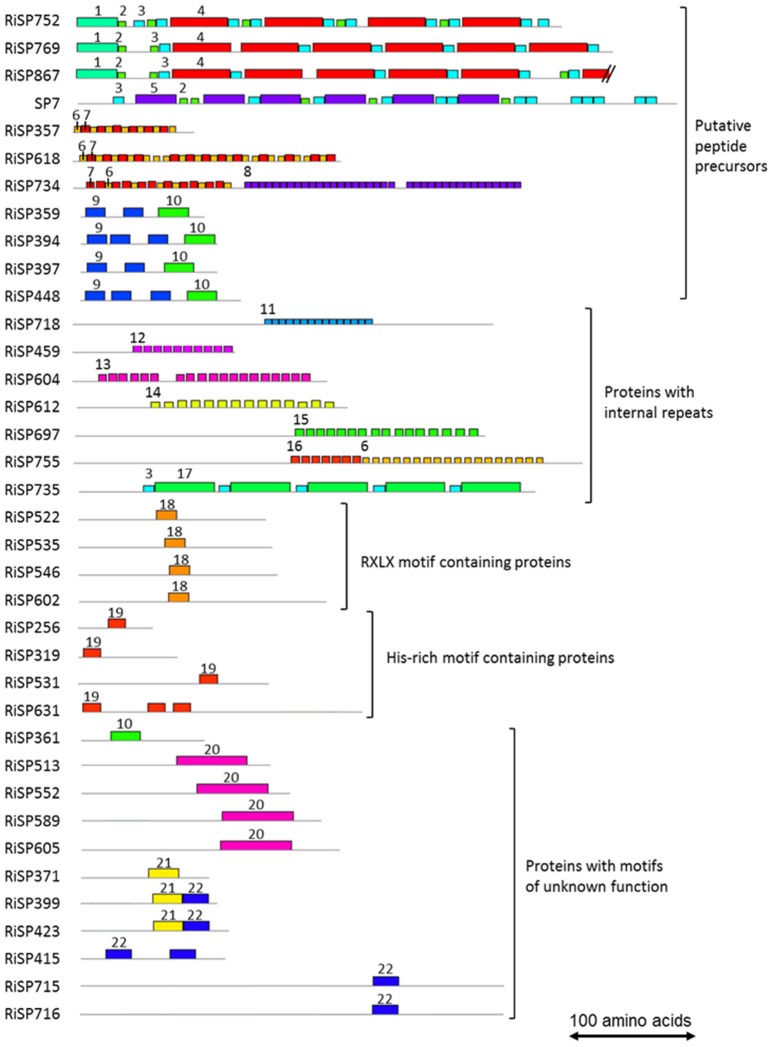
Motifs identified in RiSPs through a MEME search. Proteins are grouped according to their motif content, predicted maturation, or putative function. Motif sequences are listed in Figure S2. Each motif is illustrated by an unique color box and a number. To facilitate readability, numbers are mentioned only once for each proteins.